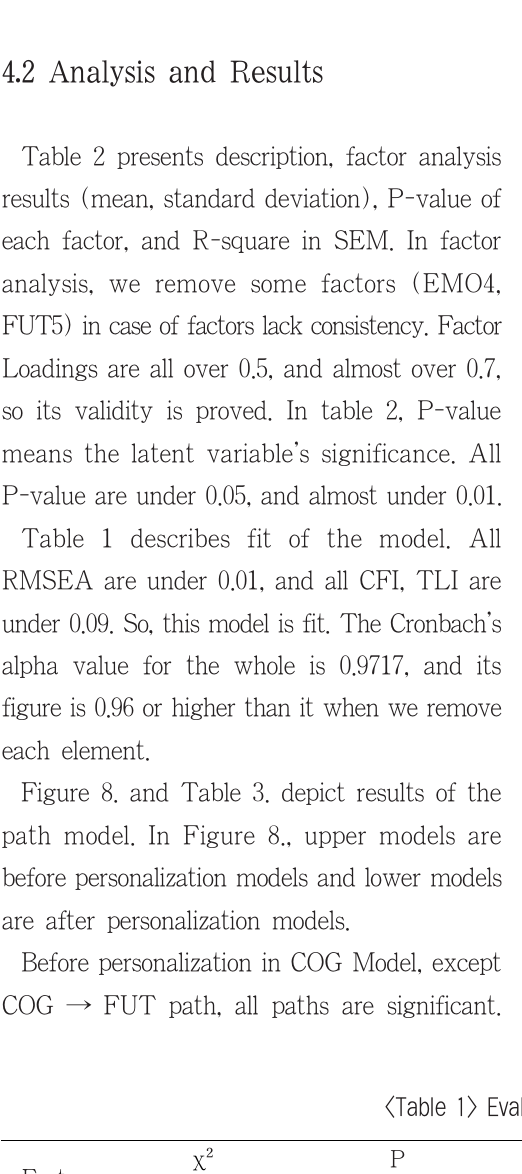
<Table 1> Evaluating Model